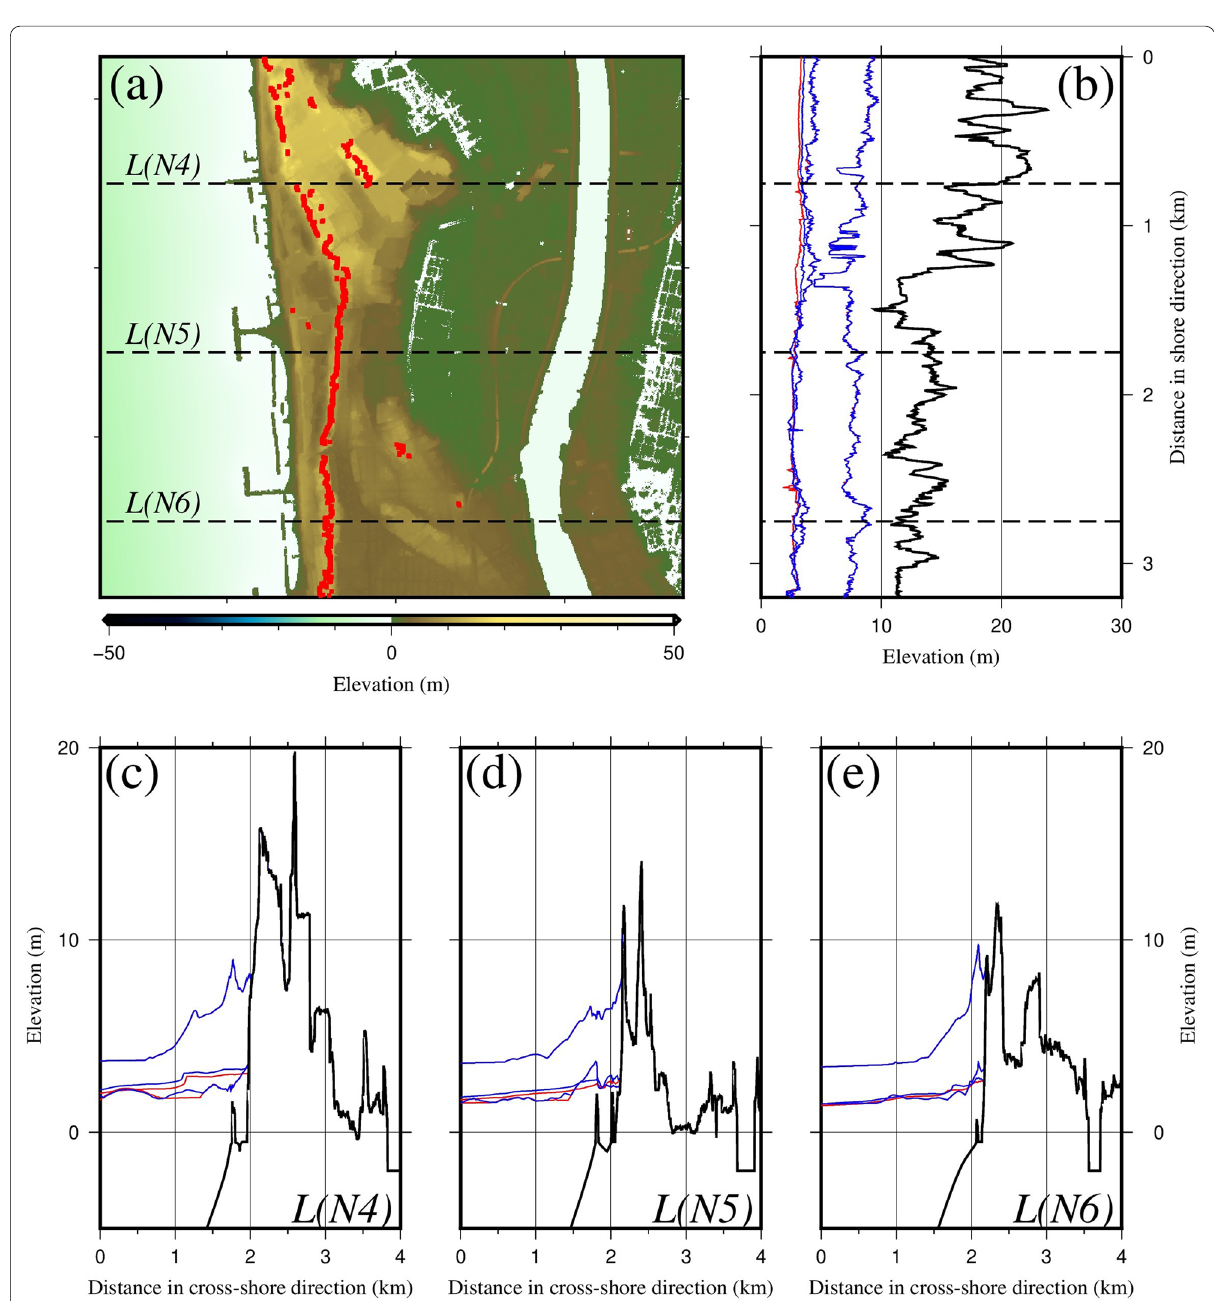
Fig. 6 Tsunami characteristics over the Niigata dune. a the geometry and cross-sectional slices within the gray area specified in the bottom-right panel of Fig. 3, red circles indicate the highest locations along the cross-shore direction, and the thick interval was 1 km; b alongshore variations in the maximum run-up heights and the top elevation over the dune; c – e profiles of the dune and the maximum water surface elevation (inundation height) along the cross-sectional slices. Each line color in ( b – e ) indicates the dune profile (black) and the tsunamis in the F34, F35, and F38 source scenarios with the breakwaters (blue) and without